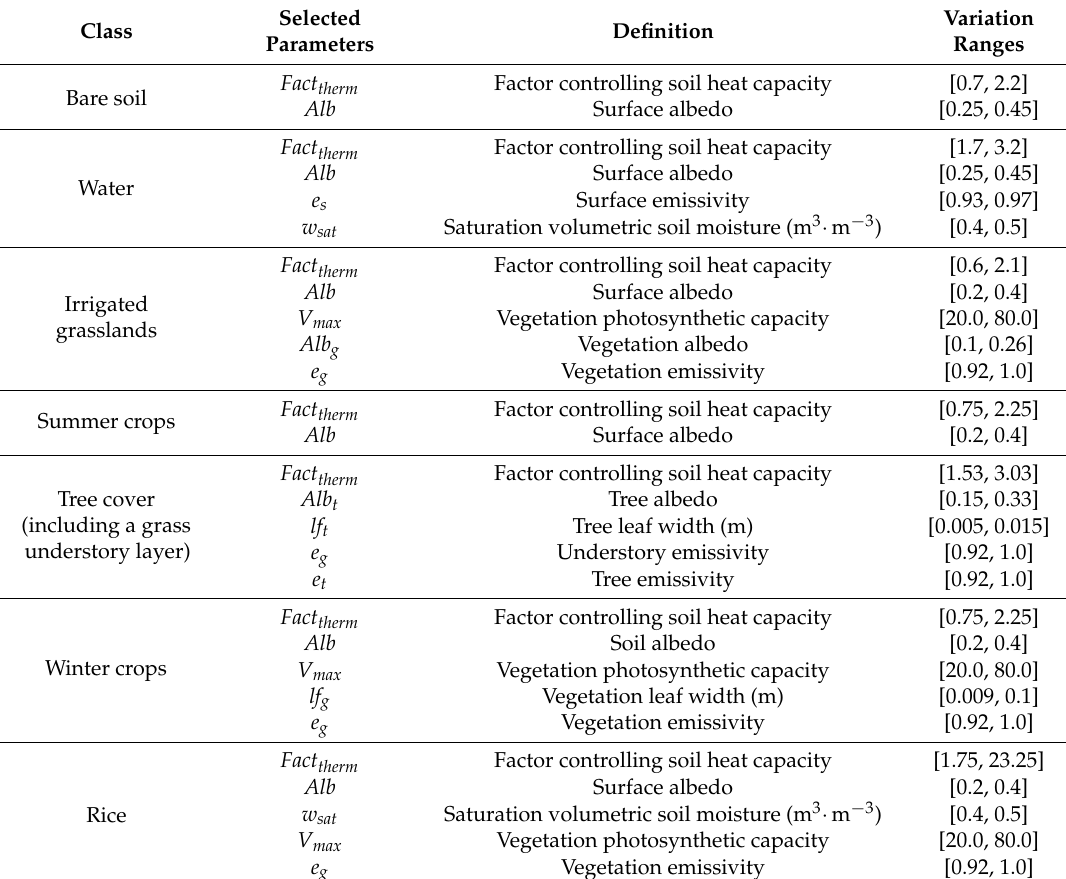
Table 1. Description of the selected parameters for the considered land cover